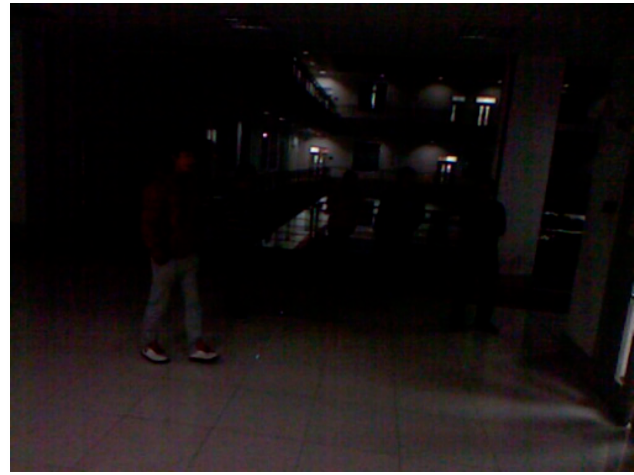
Figure 24. Example of an original image from an open database captured in a real low-light environment. Table 19. Comparison of EERs using the proposed method and state-of-the-art face and body recognition methods with an open database (unit: %).